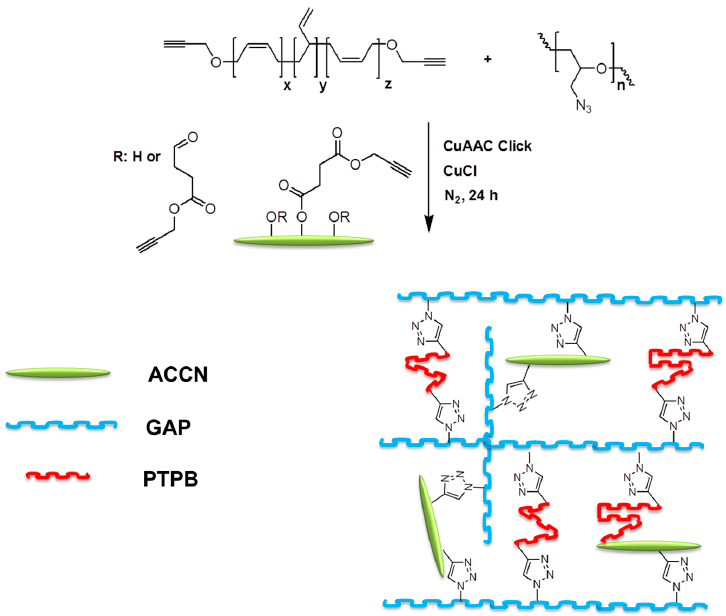
Figure 1. Formation of nanocrystal cellulose-based nanocomposites via CuAAC click